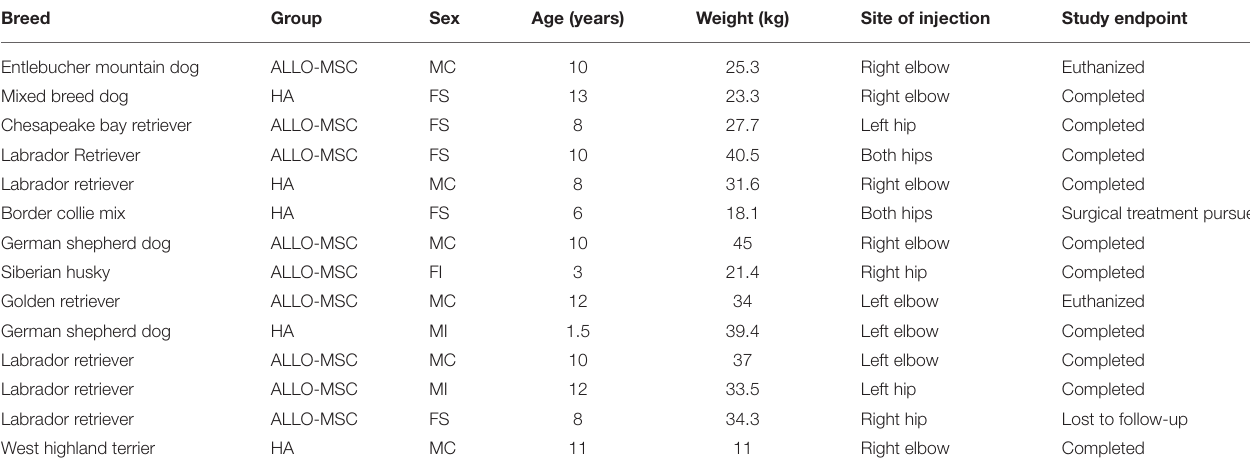
TABLE 1 | Overview of the study